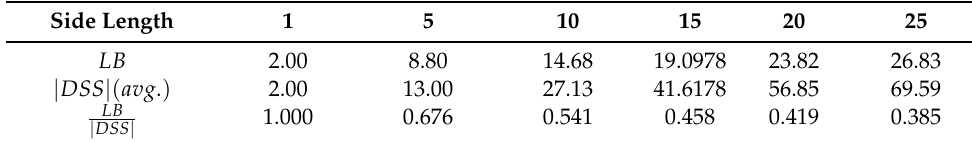
Table 3. Experimental results on grid with almost uniform